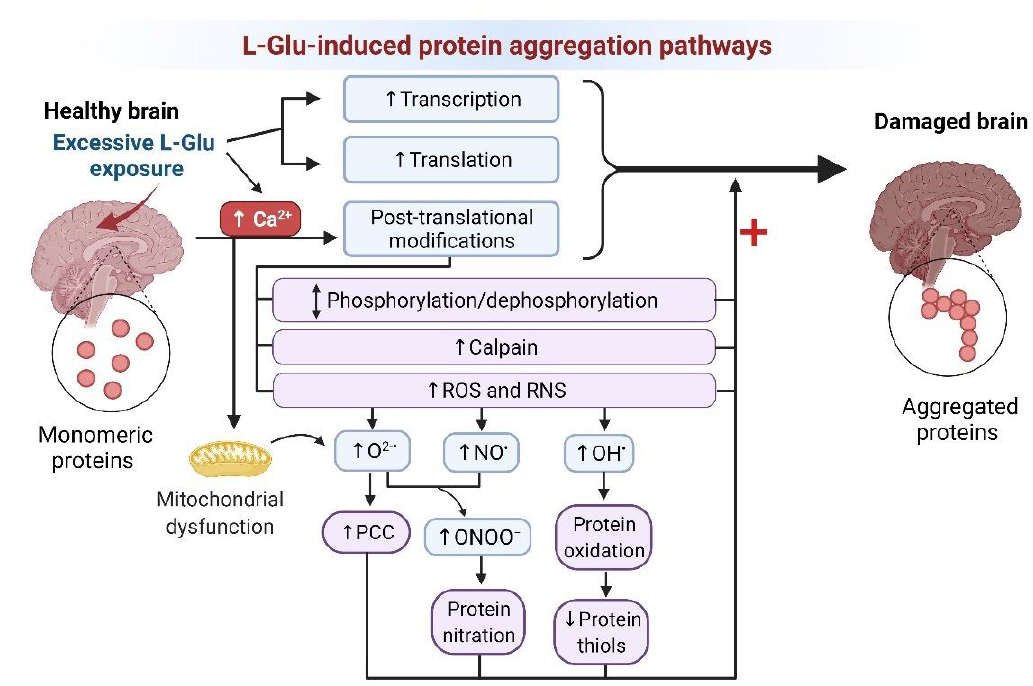
Figure 3. L-Glu induction of neurotoxic protein aggregation mechanisms reported from in vitro and in vivo model studies. Excessive L-Glu exposure can potentially induce pro- tein aggregation in neurons via an influence on transcription, translation, or protein post-translation modifications (PTMs). High L-Glu in the synaptic cleft induces exci- totoxicity, resulting in high Ca 2+ influx into neurons, and this triggers protein PTMs.